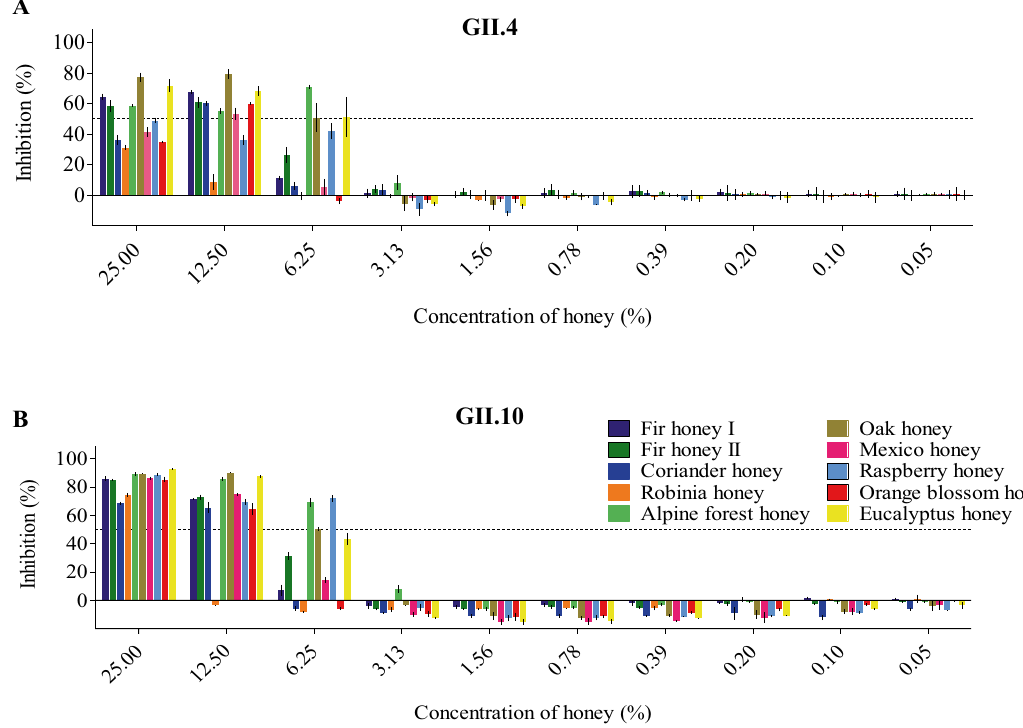
Figure 4. Honey samples blocking GII.4 and GII.10 VLP attachment to HBGAs. VLPs were mixed with serially diluted honey samples (fir I, fir II, coriander, Robinia, Alpine forest, Oak tree, Mexico, raspberry, Orange blossom, and eucalyptus). HBGA attachment inhibition was measured using ELISA. The final concentration of the honey samples ranged between 25 and 0.05%. All experiments were performed in triplicates and standard deviation is shown by the error bars. The IC 50 cutoff is shown by the dashed line. ( A ) For GII.4 VLPs, raspberry honey and alpine forest honey blocked at the lowest concentrations (IC 50 = 4.72% and 4.78%, respectively) followed by Oak tree honey (IC 50 = 5.85%) and eucalyptus honey (IC 50 = 6.22%). ( B ) For GII.10 VLPs, Alpine forest honey blocked at the lowest concentration (IC 50 = 3.38%), followed by raspberry honey (IC 50 =